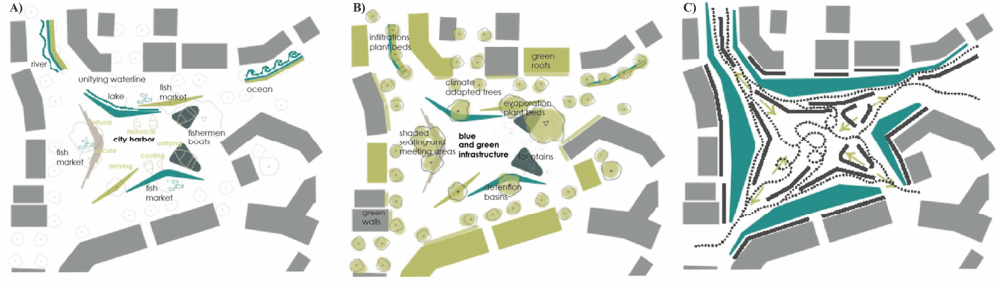
Figure 6. The three dimensions (atmosphere ( A ), function (B), space ( C )), linked in the city centre creating a sense of place and bounding elements to tell the story of Albufeira‘s history and reminding people of the name of the city in Arabic, Al uhera (the lagoon by the sea), in a symbolic